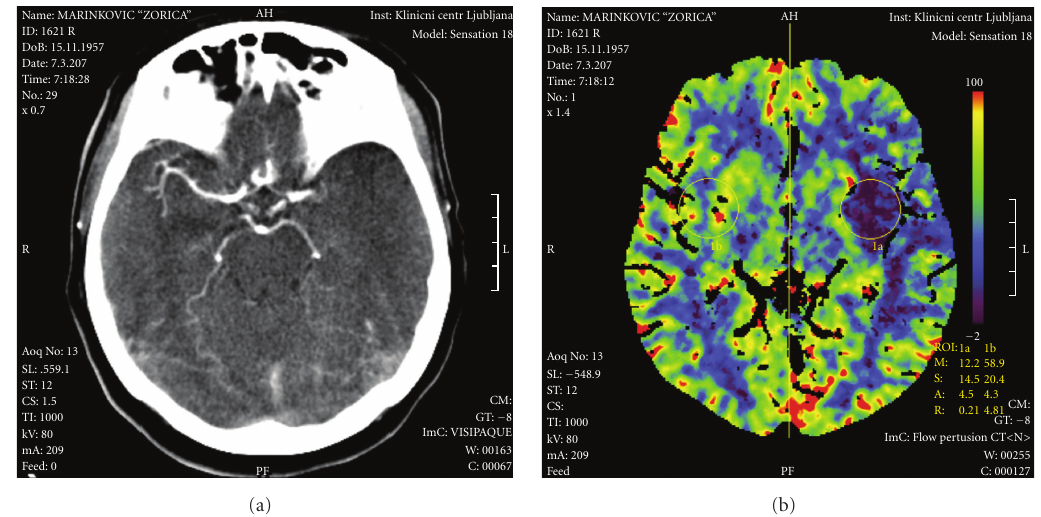
Figure 1: (a) Contrast-enhanced cranial CT with discontinuation of left MCA. (b) CT perfusion test revealed increased time to peak in the velocity.